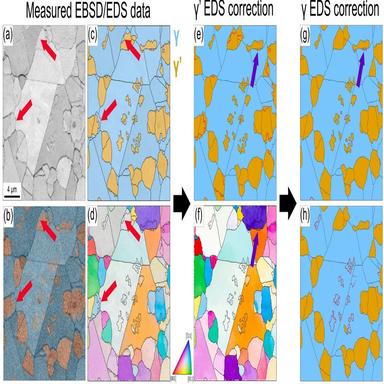
Microstructure of Alloy 1 with γ grains as well as primary and secondary γ' collected with combined EBSD-EDS where GBs with misorientation θ > 5◦ and interphase boundaries are marked in black. The measured and uncorrected (a) band contrast map, (b) EDS map with regions high in Cr in blue (γ) and regions high in Ti in orange (γ'), (c) phase map with γ in blue and γ' in orange, and (d) IPF map. After EDS correction of γ': (e) phase map with changed interphase boundaries marked in red along which γ interface a